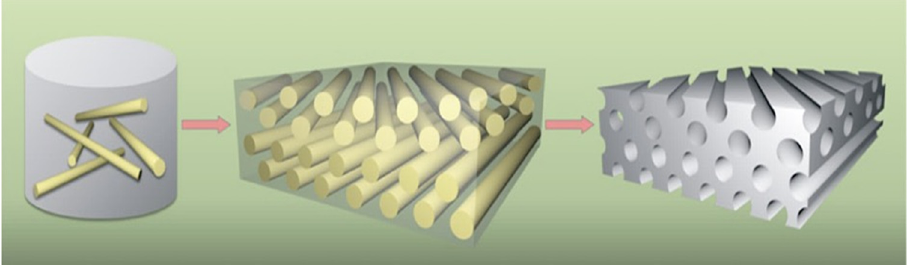
Figure 10. The synthesis approach to the NCC-templated mesoporous TiO 2 film. Reprinted with permission from [ 15 ] . Copyright 2014 American Chemical Society.